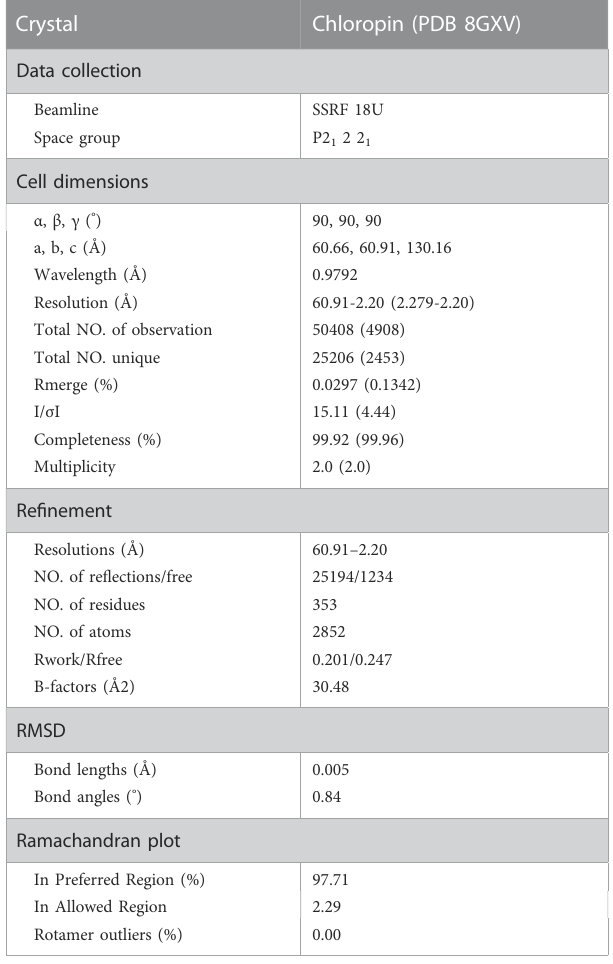
TABLE 1 Data processing, re fi nement, and model